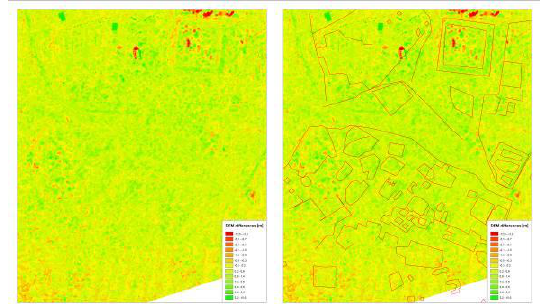
Figure 25 – DEM comparison with GSD of 1m (RPAS image has been set as a